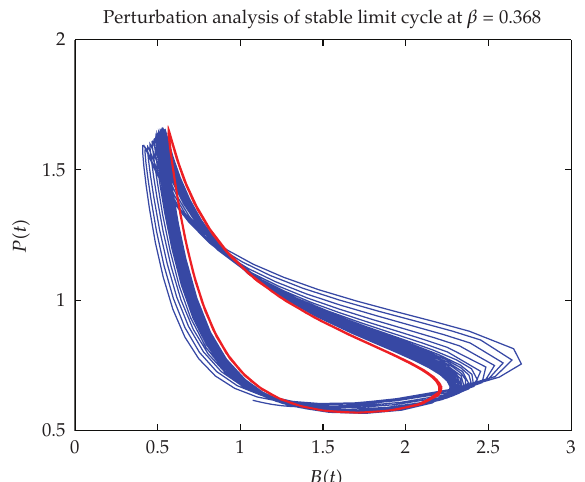
Figure 7: The stable limit cycle (cid:5) red (cid:6) and the perturbation solutions (cid:5) blue (cid:6) for perturbations above and below the limit cycle.